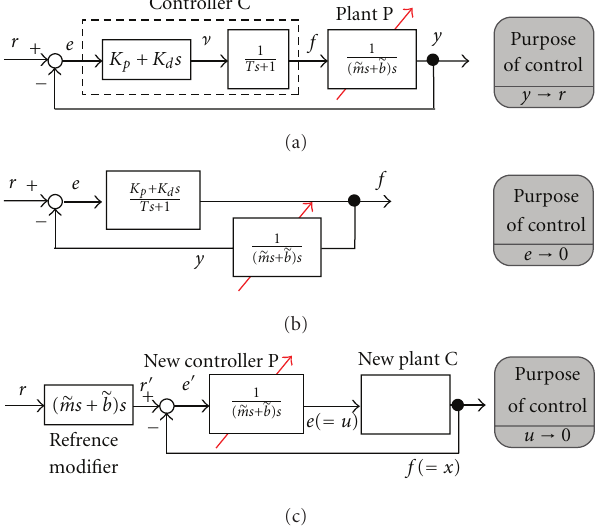
Figure 9: Transformation of block diagrams for variable dynamics control.